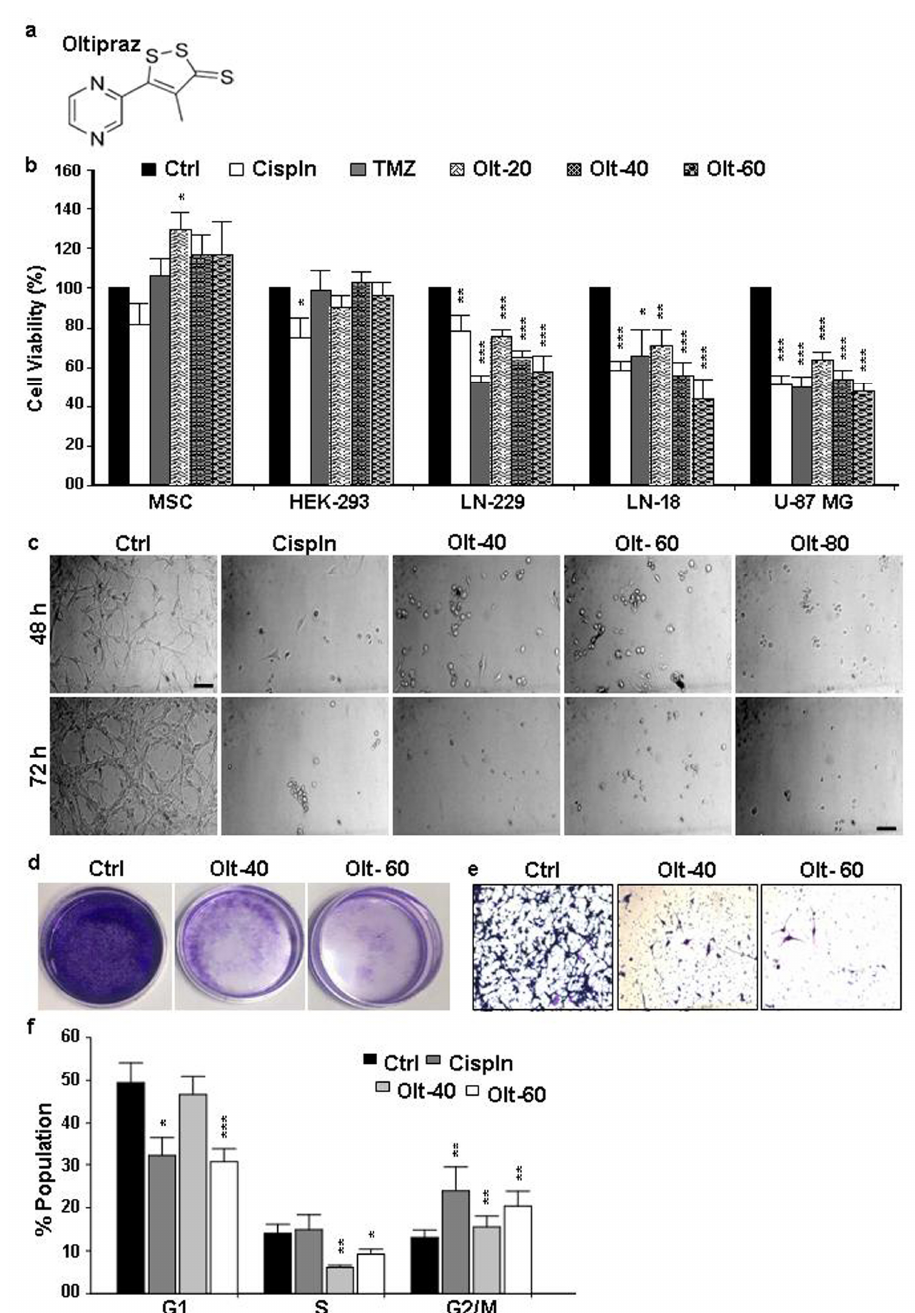
Figure 1. The inhibitory effect of Olt on GBM cell growth: ( a ) The chemical structure of Olt. ( b ) MTT assay depicting the % cell viability in normal (MSC), non-tumorigenic (HEK-293), and GBM (LN18, LN229, and U-87 MG) cell lines after 48 h of Olt treatment (20–60 μ M) compared to the untreated control (Ctrl) group in each (considered as 100% viable). The TMZ and Cispln exposure served as the positive controls for treatment groups in GBM cells. Values are represented as mean ± SEM from independent experiments (n = 3–7). ( c ) Morphological changes in U-87 MG cells after treatment with Cispln and Olt (40-, 60- and 80 μ M) for 48- and 72 h (Scale bar 50 μ M). ( d ) Decrease in colony formation abilities of GBM cells after treatment of the Olt for 48 h. ( e ) Olt treatment (48 h) inhibited the migration of cells from the upper chamber to the lower chamber of the transwell plate. Scale bar: 100 µ M. ( f ) Flow cytometry analysis shows Olt-induced reduction in G1 and S phases and G2/M phase arrest in the cell cycle in U-87 MG cells. Data are presented as mean ± SEM (n = 6). * p ≤ 0.05; ** p ≤ 0.01; *** p ≤ 0.001 compared to the untreated Ctrl